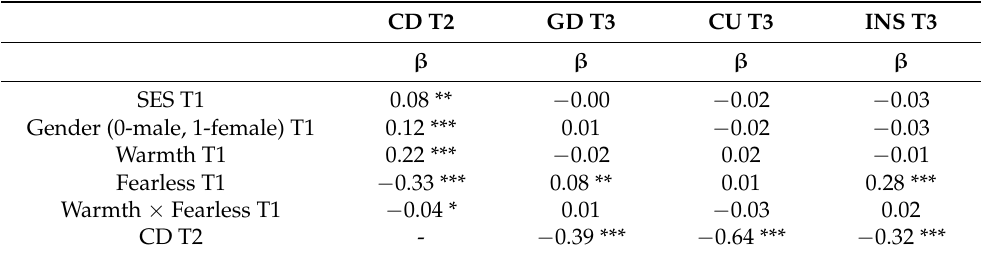
Table 2. Standardized direct effects from the SEM testing the conceptual model of conditional indirect effects.